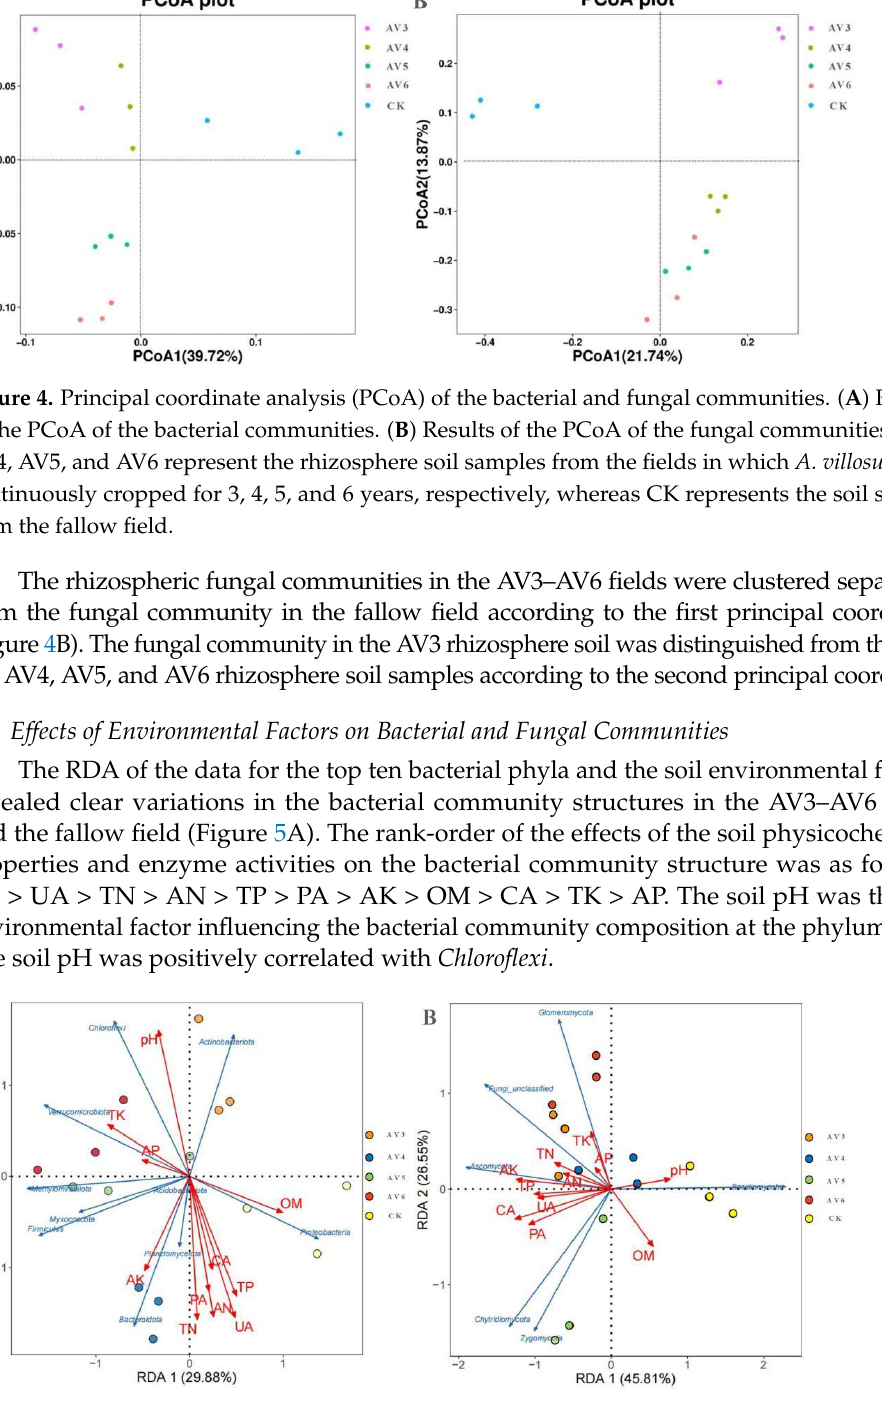
Figure 5. Correlations among microbial phyla, soil physicochemical properties, and soil enzyme activities. ( A ) Results of the redundancy analysis (RDA) of the dominant bacterial phyla, soil physicochemical properties, and soil enzyme activities. ( B ) Results of the RDA of the dominant fungal phyla, soil physicochemical properties, and soil enzyme activities. AV3, AV4, AV5, and AV6 represent the rhizosphere soil samples from the fields in which A. villosum was continuously cropped for 3, 4, 5, and 6 years, respectively, whereas CK represents the soil sample from the fallow